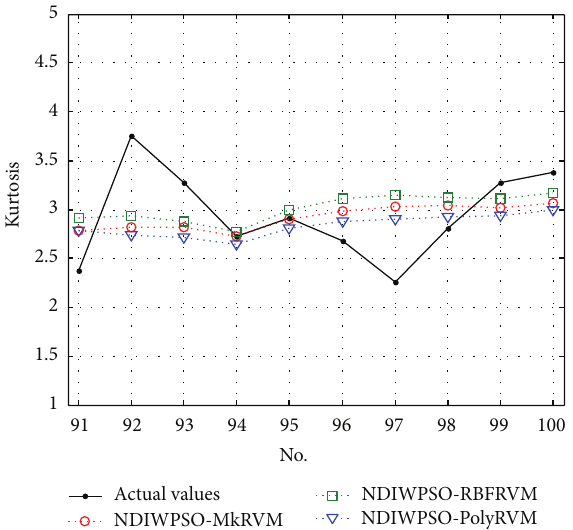
Figure 6: The comparison of the prediction results for kurtosis of bearing vibration signal among NDIWPSO-MkRVM, NDIWPSO- RBFRVM and NDIWPSO-PolyRVM in case 3.